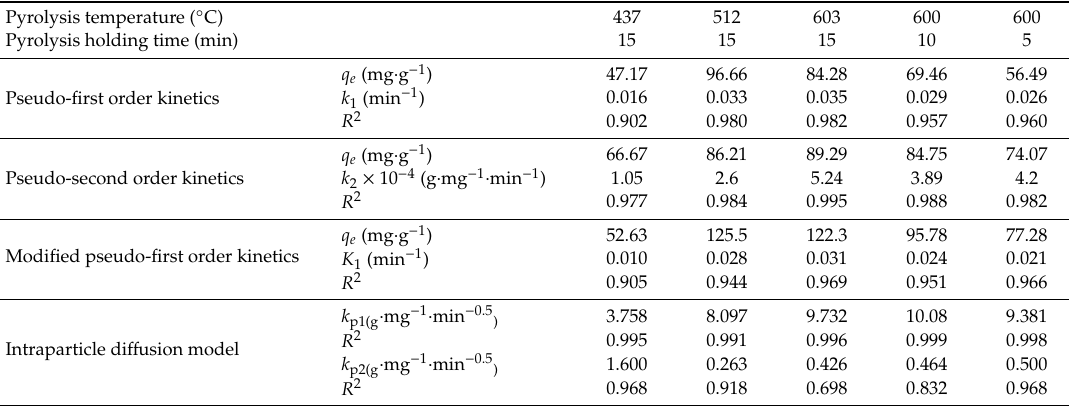
Figure 4. Effect of pyrolysis temperature on adsorption kinetics of char. ( a ) pseudo-first-order kinetics model; ( b ) pseudo-second-order kinetics model; ( c ) modified pseudo-first-order kinetics model; ( d ) intraparticle diffusion model. Table 2. Fitting parameters for di ff erent kinetics